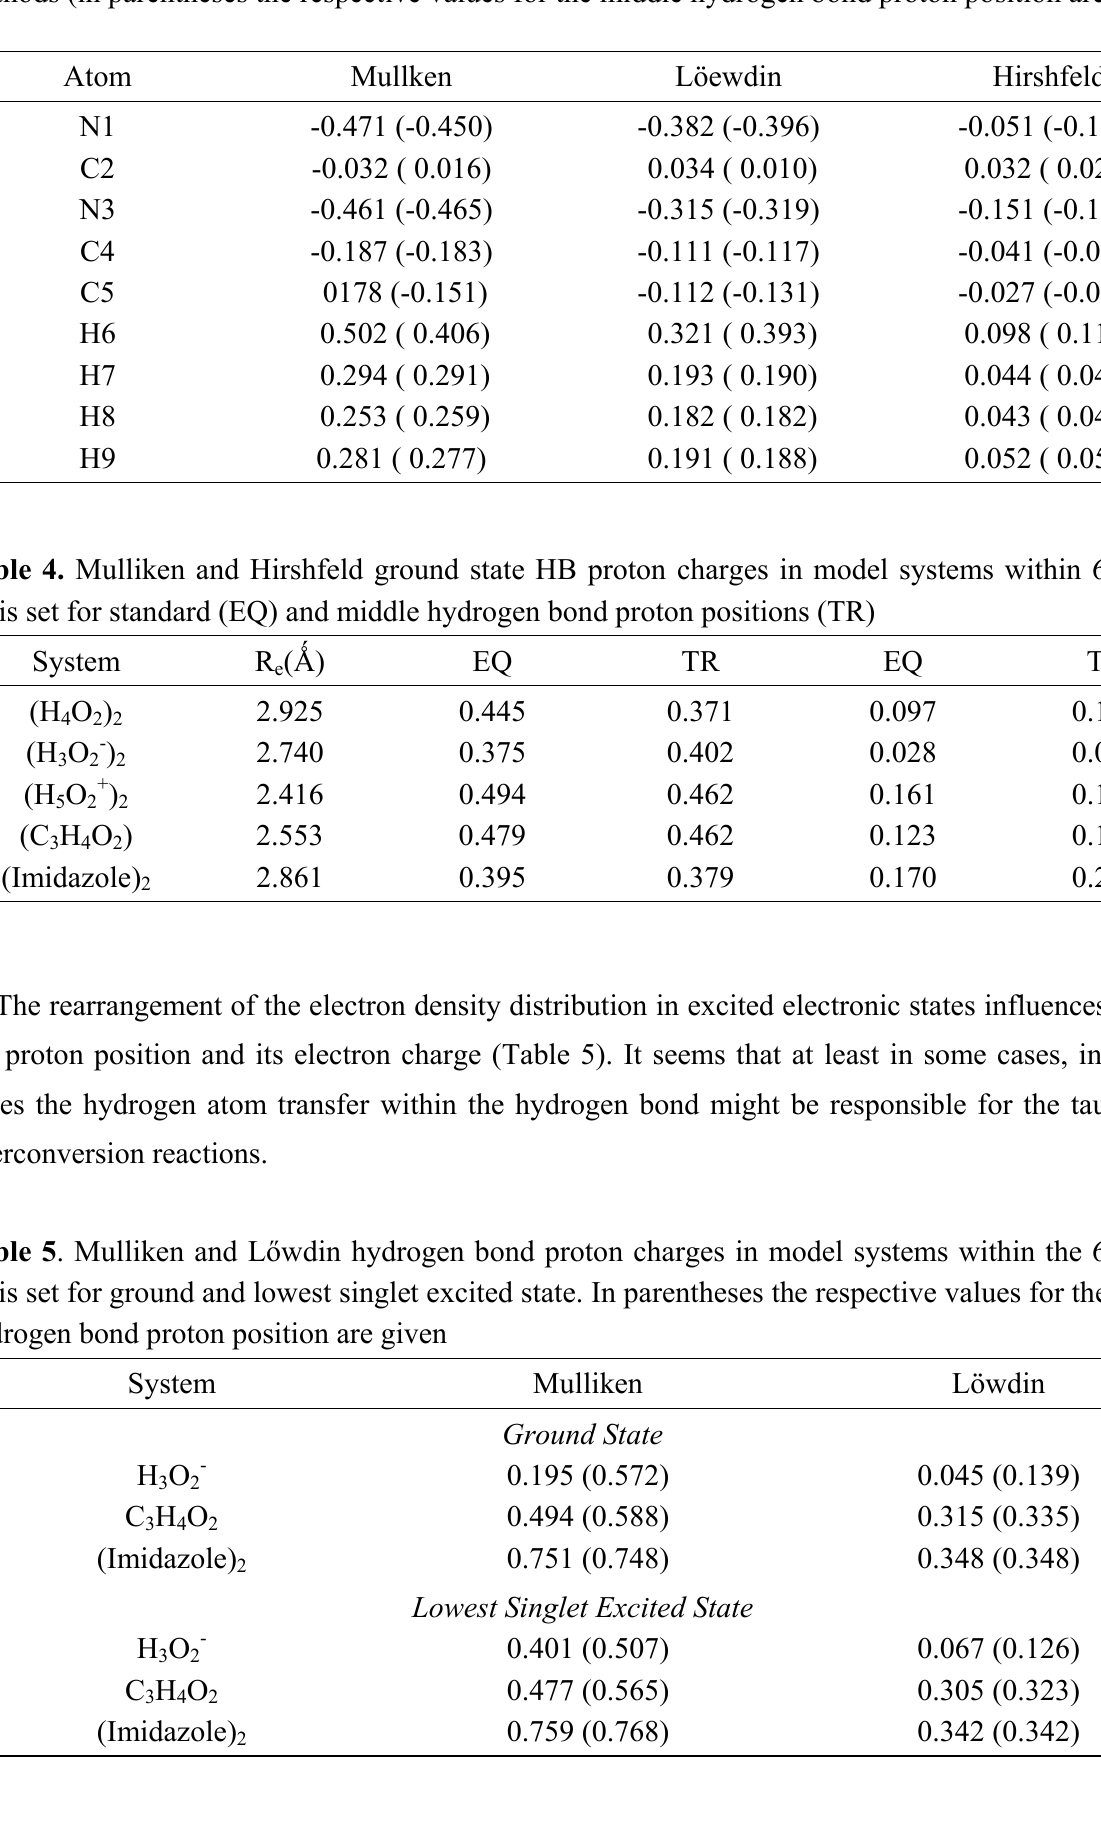
Table 3. Atomic charges for the imidazole molecule according to Mulliken, Löwdin and Hirshfeld methods (in parentheses the respective values for the middle hydrogen bond proton position are given)